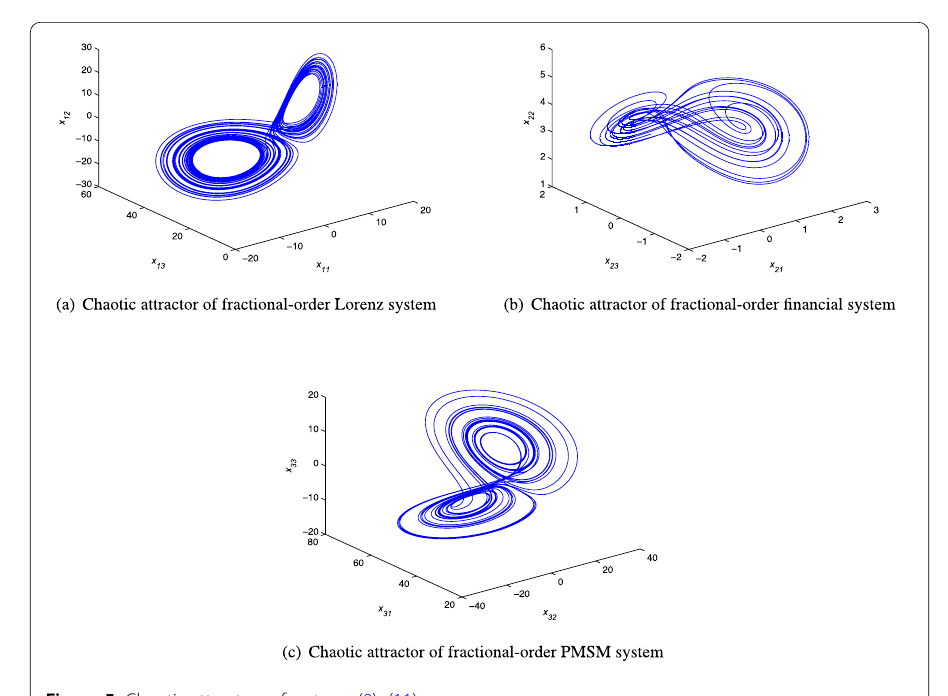
Figure 5 Chaotic attractors of systems (9)–(11)